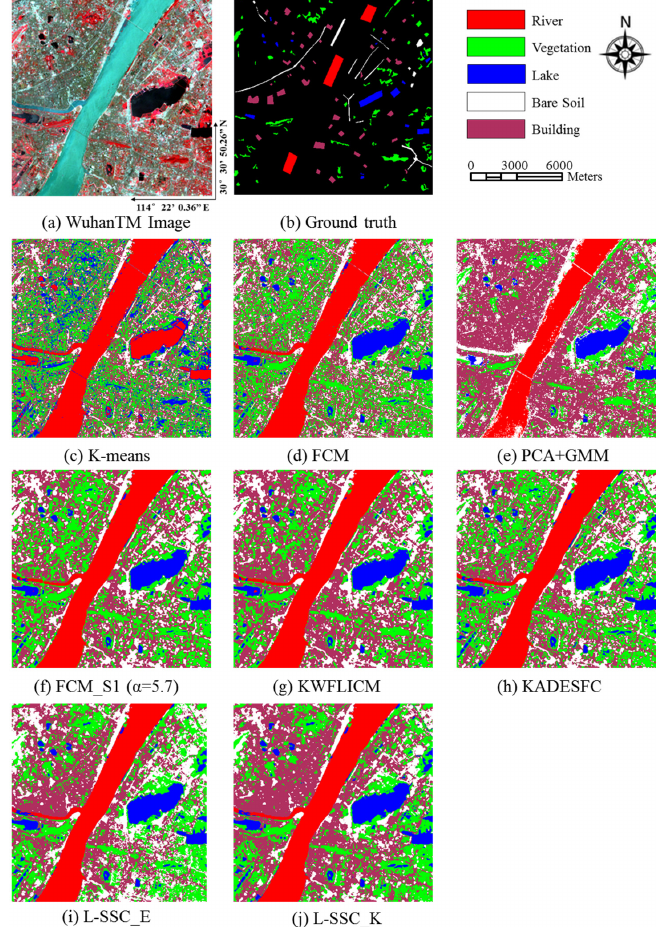
Figure 8. Wuhan TM image and the clustering results. ( a ) WuhanTM image; ( b ) Groundtruth; ( c ) K-means; ( d ) FCM; ( e ) PCA+GMM; ( f ) FCM_S1; ( g ) KWFLICM; ( h ) KADESFC ( i ) L-SSC_E and ( j ) L-SSC_K